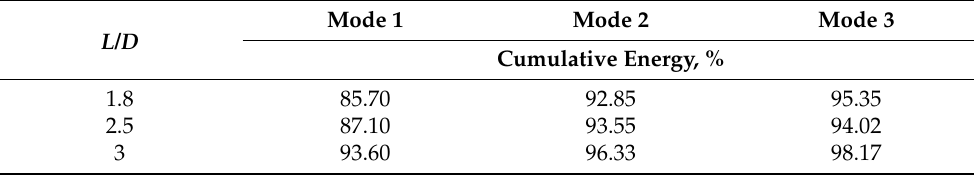
Table 5. Energy levels of the DMD modes and their respective contributions to the total energy.